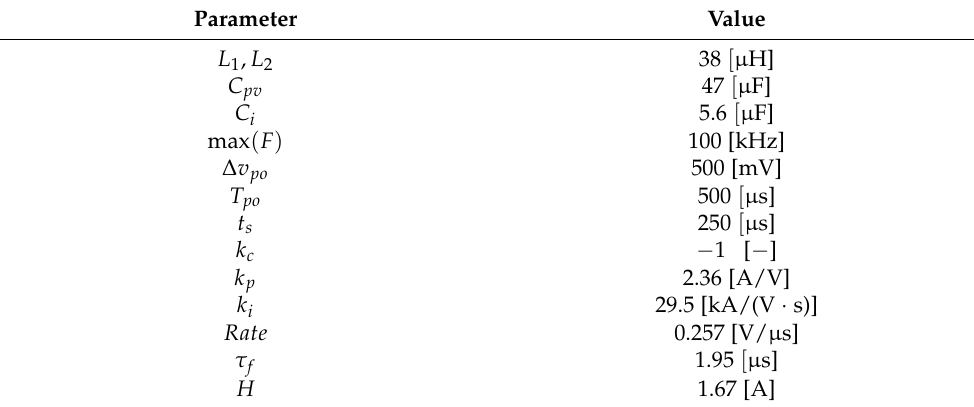
Table 2. Design example of the PV system based on the CIOC converter.